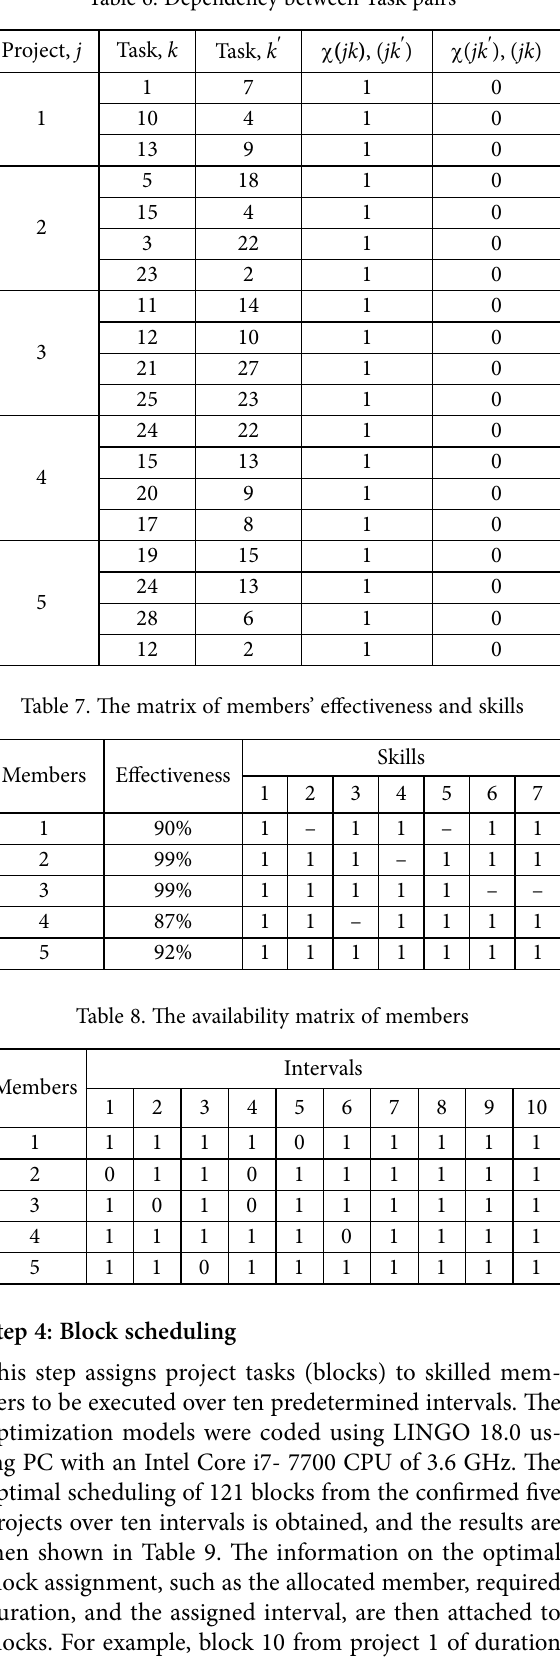
Table 6. Dependency between Task pairs